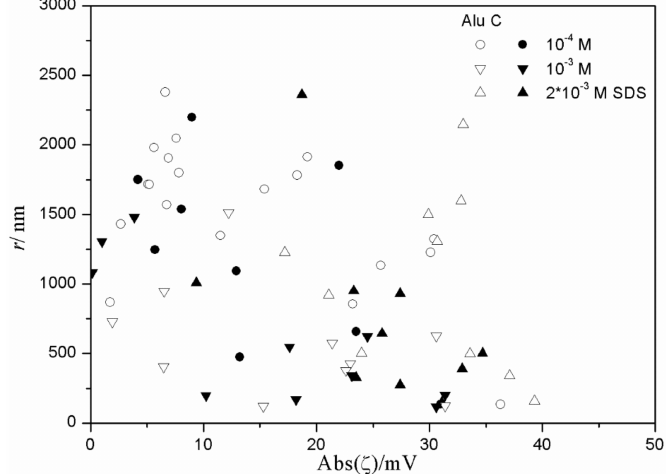
Figure 14. The particle size as a function of | ζ | in fresh (white points) and aged (black points) dispersions of alumina in the presence of sodium dodecylsulfate.